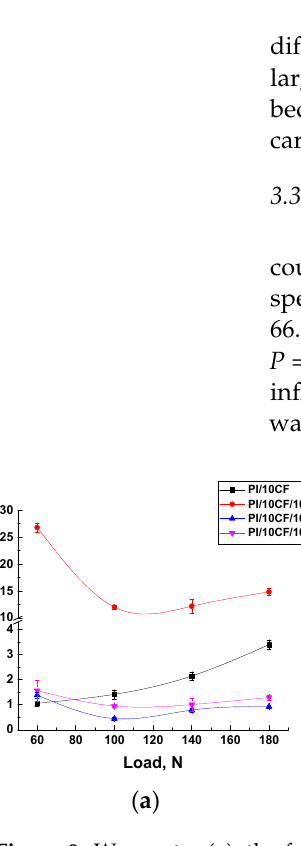
Figure 9. Wear rates ( a ), the friction coefficients ( b ) and the counterpart temperatures ( с ) on the friction surfaces of the PI-based composites.